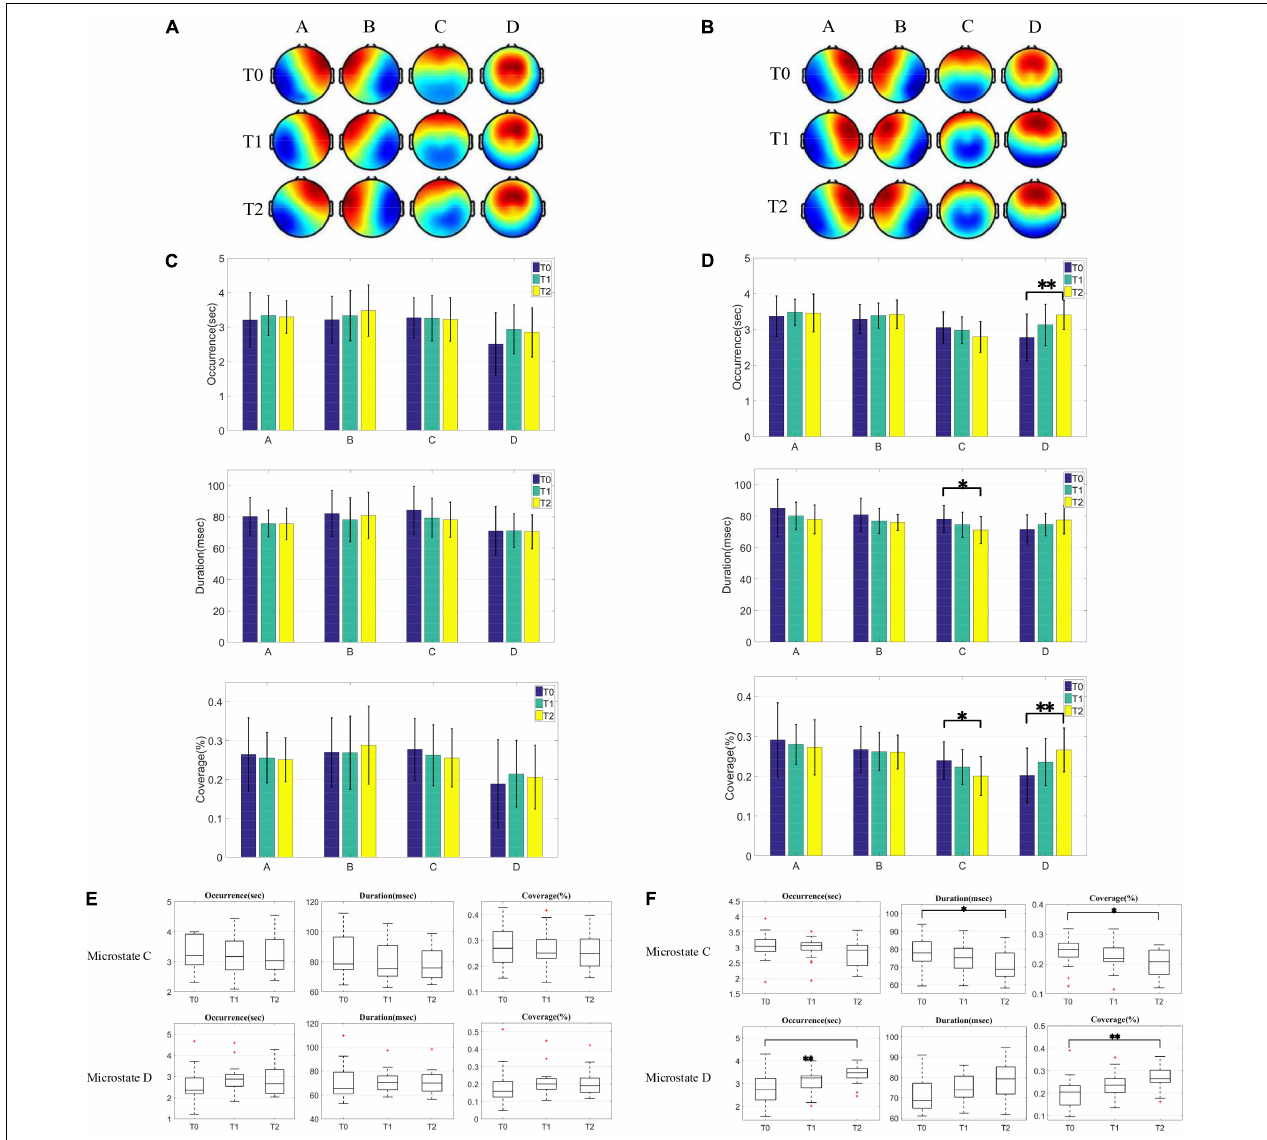
FIGURE 2 | Comparison of microstates topographic maps and microstates parameters between the unimproved group and improved group. (A,B) Microstate topographic map of the unimproved group and improved group before and after HD-tDCS treatment. (C,D) Two-tailed t -test was used to compare the three microstate parameters (OPS, MMD, and Cov) in the four microstates between group U and group I before and after HD-tDCS treatment, and FDR correction was used to correct for multiple comparison results. (E,F) Dynamic changes of parameters of microstate C and D parameters in the unimproved group and improved group during HD-tDCS